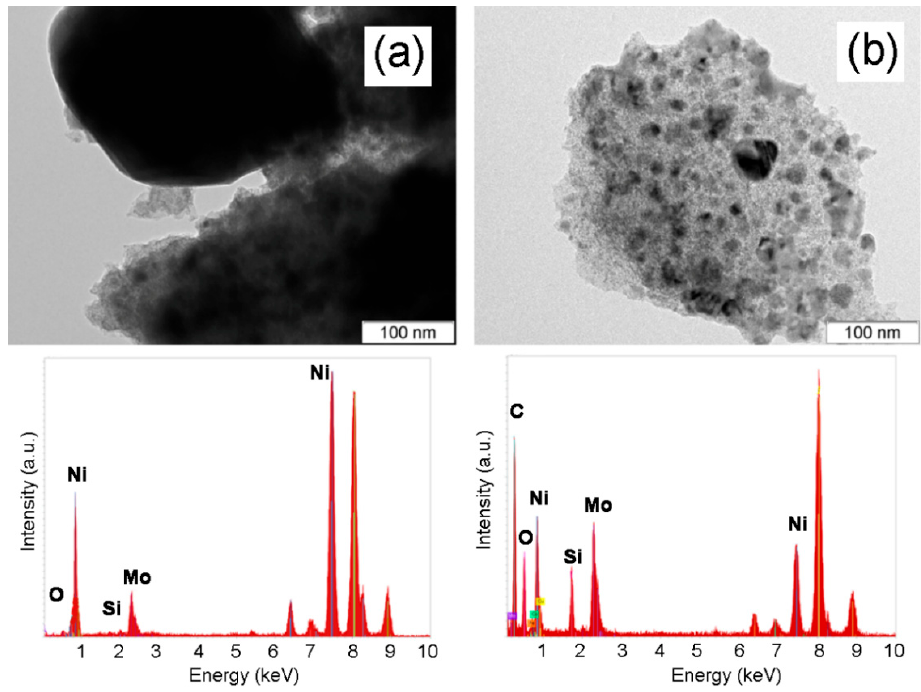
Figure 9. TEM images of the reduced Ni 1 MoC–SiO 2 (400/600) catalyst with corresponding EDX patterns.